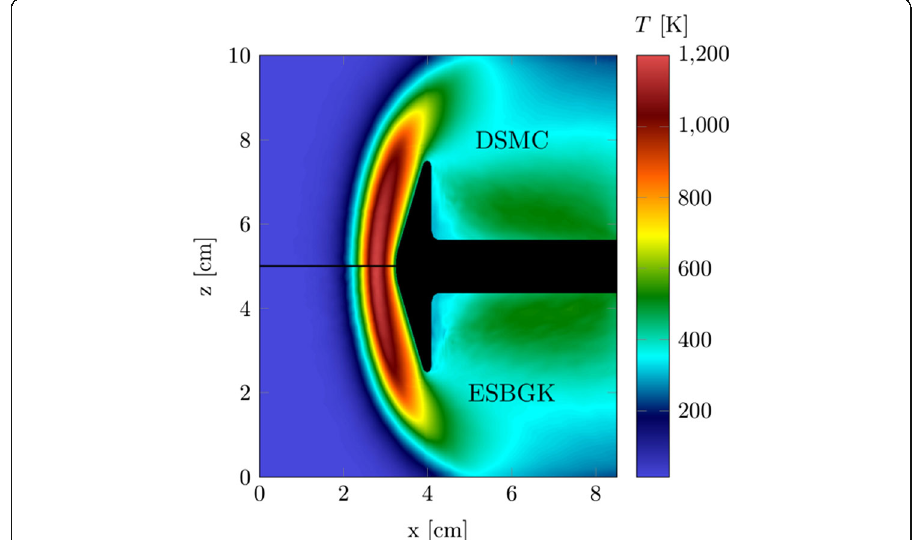
Fig. 4 Translational temperature contours of the 70° blunted cone obtained using ESBGK and DSMC